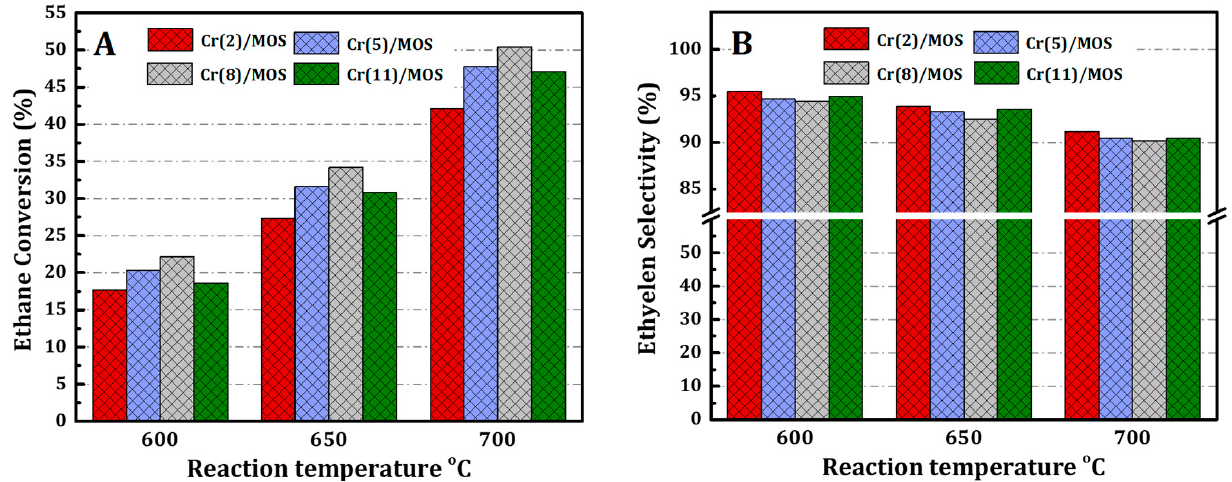
Figure 6. Effects of Cr loading on ethane conversion ( A ) and ethylene selectivity ( B ) for Cr(x)/MOS catalysts at various reaction temperatures. Reaction conditions: temperature = 700 °C; feed composition C 2 H 6 /CO 2 /N 2 = 1/5/4; catalyst weight = 300 mg; reaction time = 1.0 h.